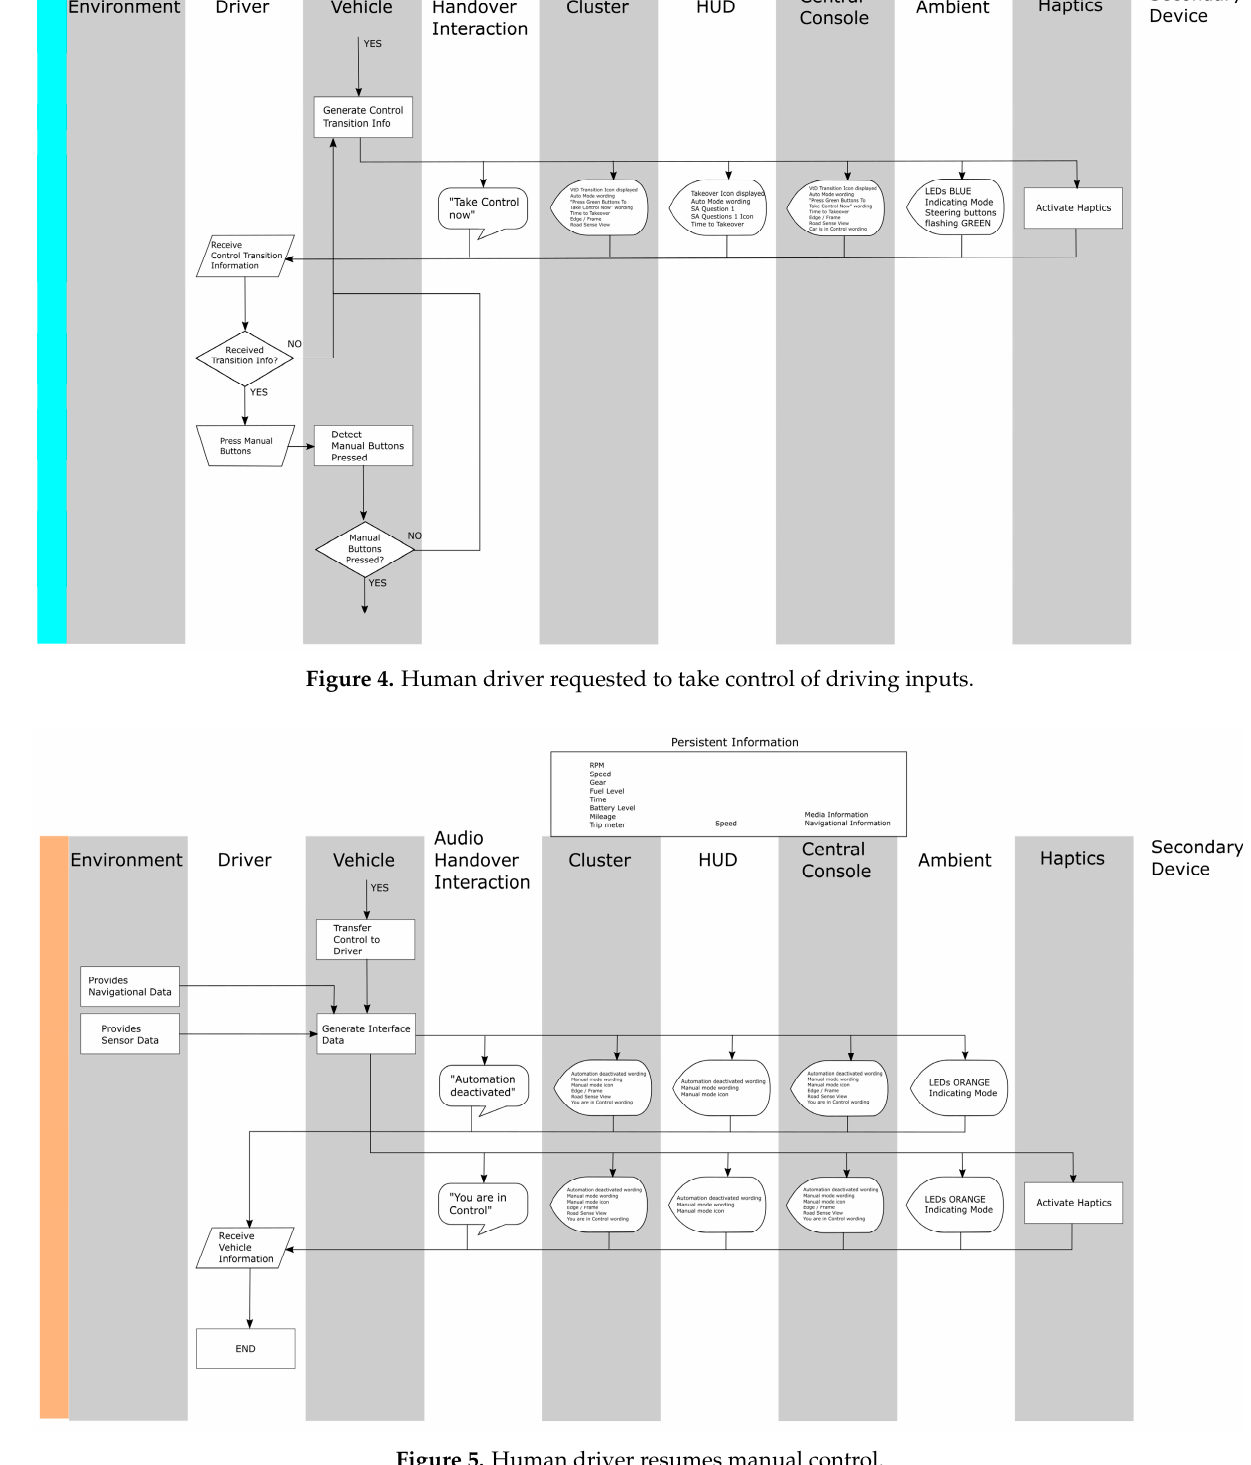
Figure 5. Human driver resumes manual control. If the driver chooses to engage vehicle automation, then they would press two buttons on the steering wheel with their thumbs simultaneously (assuming that their hands are